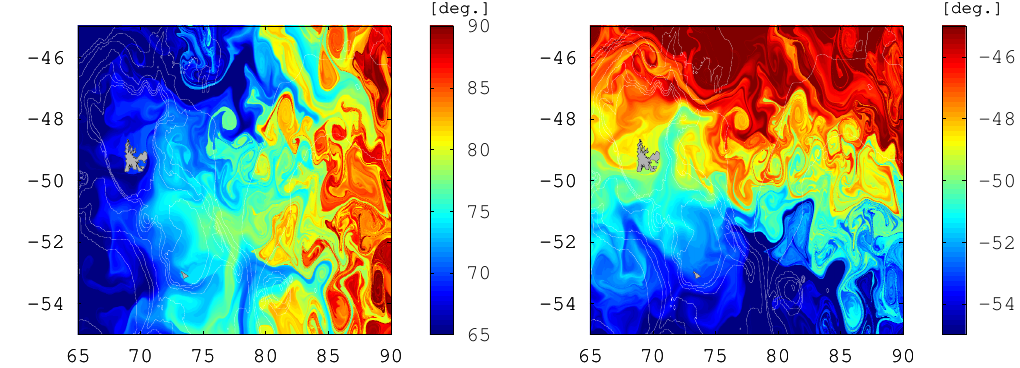
Figure 5. Altimetry-derived 30 day horizontal origin. Left: longitude. Right: latitude.